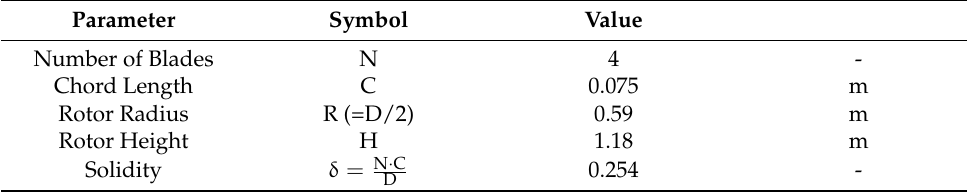
Table 1. Characteristics of